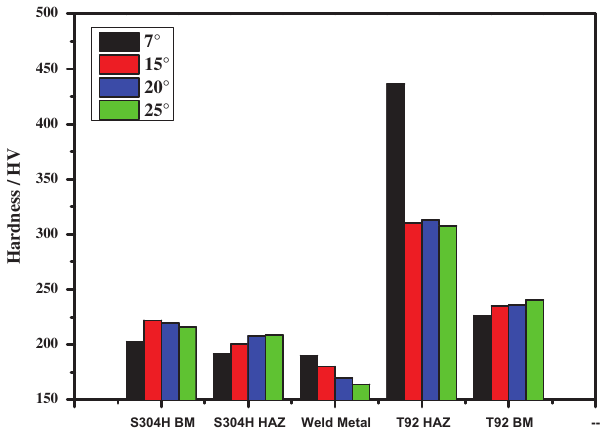
Figure 6: Microhardness of T92/Super 304H dissimilar weld joints.